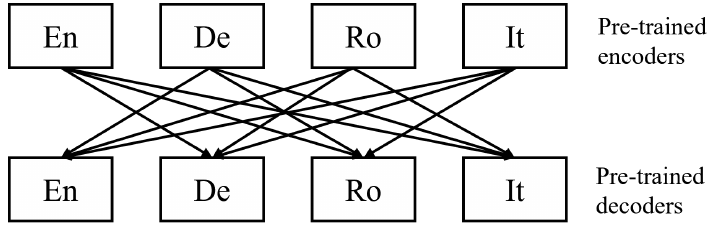
Figure 3. Illustration of cross-connection among multiple pre-trained encoders and decoders. The intermediate layer is omitted for simplification. When creating a translation model, we can pick and compose a proper module for each language among the pre-trained encoders and decoders. Thus, we can use the composition of monolingual models such as a pseudo-multilingual pre-trained